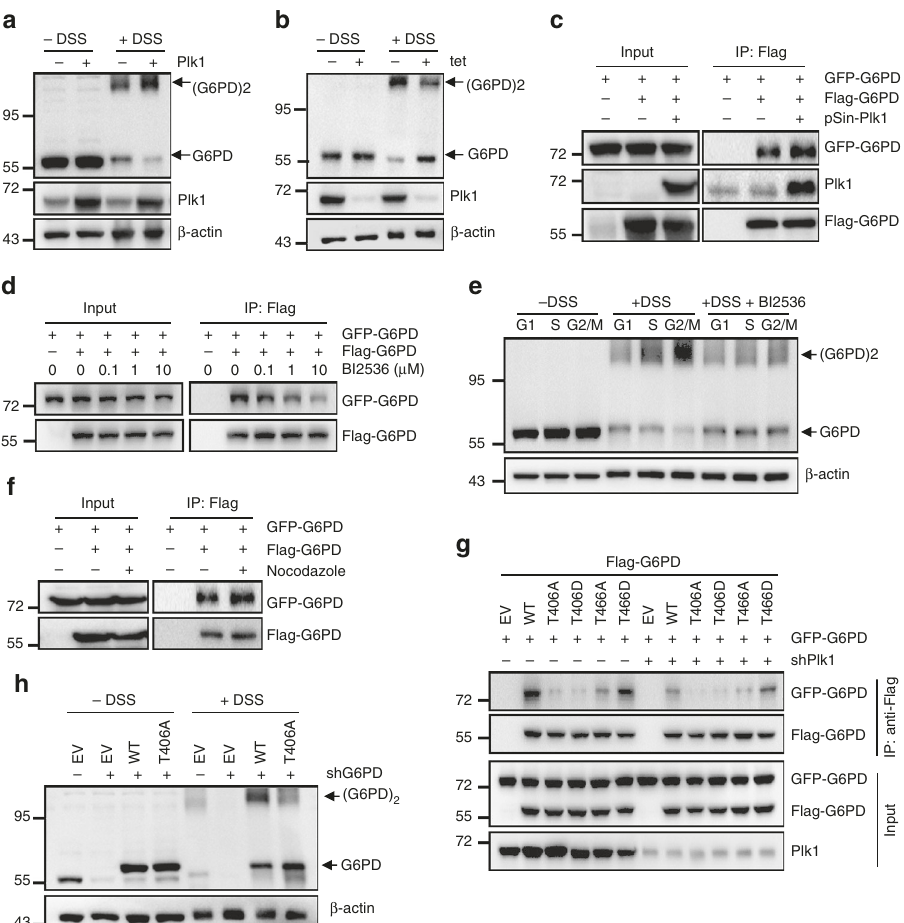
Fig. 5 Plk1-mediated G6PD phosphorylation promotes its dimerization. a , b HeLa cells overexpressing Plk1 ( a ) or expressing tet-inducible shPlk1 ( b ) were treated with or without 1 mM disuccinimidyl suberate (DSS), followed by western blot analysis with antibodies against G6PD or Plk1. To induce Plk1 shRNA expression, cells were grown in the presence of 0.1 μ g/ml doxycycline for 72 h. β -actin served as loading control. c HeLa cells transfected with eGFP-G6PD and Flag-G6PD vectors were co-transfected with pSin-Plk1 plasmid. Cell lysates were immunoprecipitated with anti-Flag antibody, followed by western blot analysis with antibodies against G6PD or Plk1. d GFP-G6PD and Flag-G6PD co-transfected HeLa cells were treated with BI2536 for 16 h at indicated concentrations. Cells were harvested and subjected to Co-IP using Flag antibody, followed by western blotting with Flag or GFP antibody. e HeLa cells were synchronized using HU double block during which vehicle or 1 μ M BI2536 was added 1 h before releasing. Cells were harvested and crosslinked using DSS, followed by western blotting with anti-G6PD. f HeLa cells transfected with eGFP-G6PD and Flag-G6PD were treated with nocodazole. Cell lysates were immunoprecipitated with anti-Flag antibody, followed by western blot analysis with antibodies against G6PD. g NTC- or shPlk1-expressing 293T cells were co-transfected with GFP-G6PD and Flag-G6PD wild type or mutants as indicated. Cells were harvested and subjected to Co-IP using Flag antibody, followed by western blotting with Flag or GFP antibody. h G6PD wild type or its T406A mutant was forced overexpressed in HeLa cells stably expressing shG6PD. Cells were treated with or without 1 mM DSS, followed by western blot analysis with antibodies against G6PD. β -actin served as loading